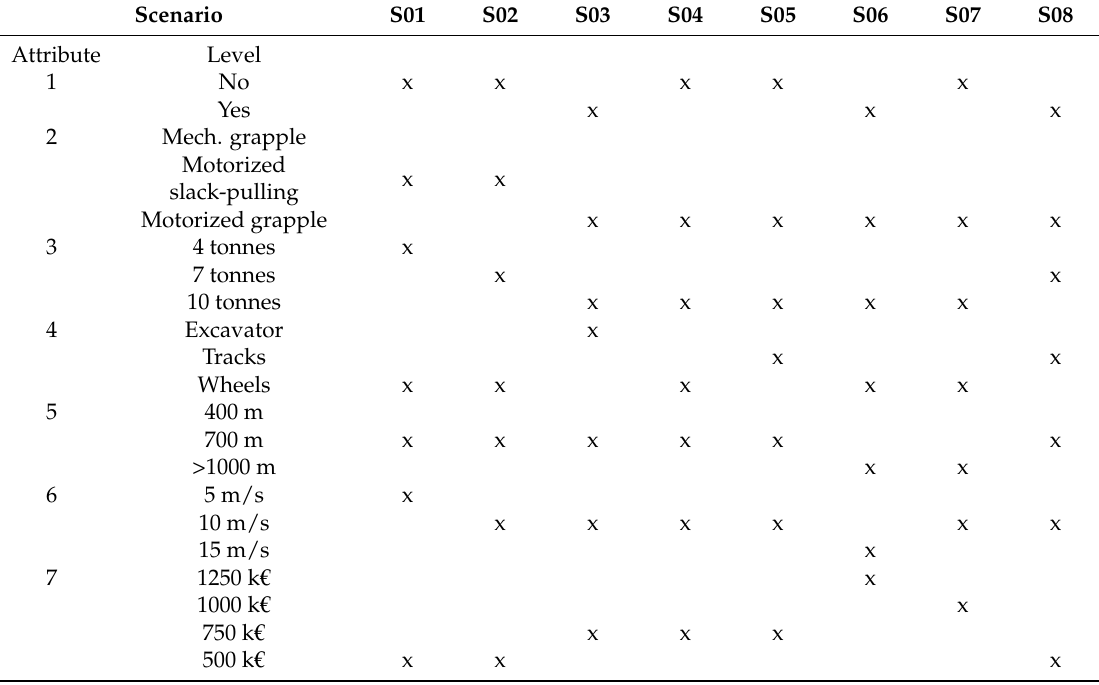
Table 2. Cable yarder design scenarios for Australia and New